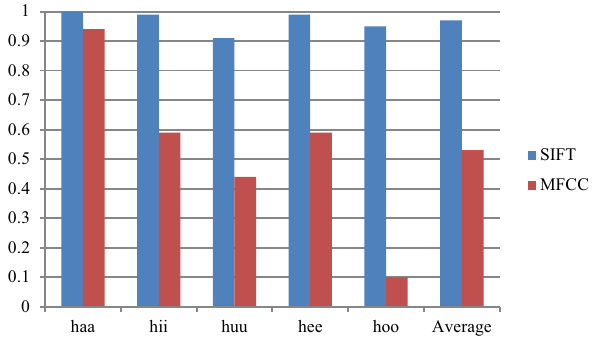
In LNBNN, we use both SIFT and MFCC features extracted from spectrogram images of speech signals. Since other classifiers need to have the same dimension input data, we use the LBG algorithm to quantize features to the same dimension.SIFTfeaturesextractedfromspectrogramimages are quantized to 16 SIFT feature points; then these 16 fea- ture points are converted to 128 × 16 dimension vectors for each sample. For MFCC features, we extract 18 MFCC coefficients from each speech signal, and then all MFCC coefficients are quantized to 16 feature vectors. After that, 16 MFCC vectors are converted to one 16 × 18 dimension